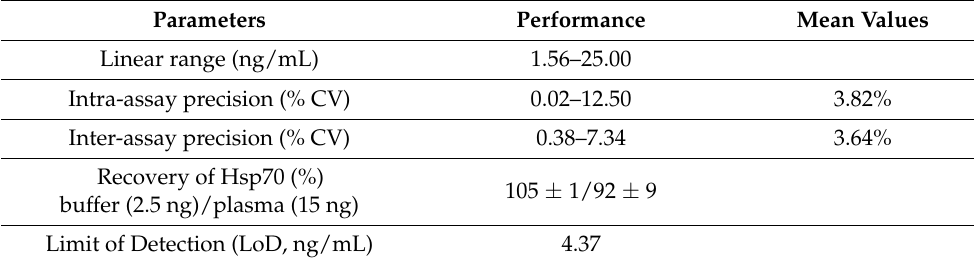
Table 2. Assay performance of the compHsp70 ELISA.